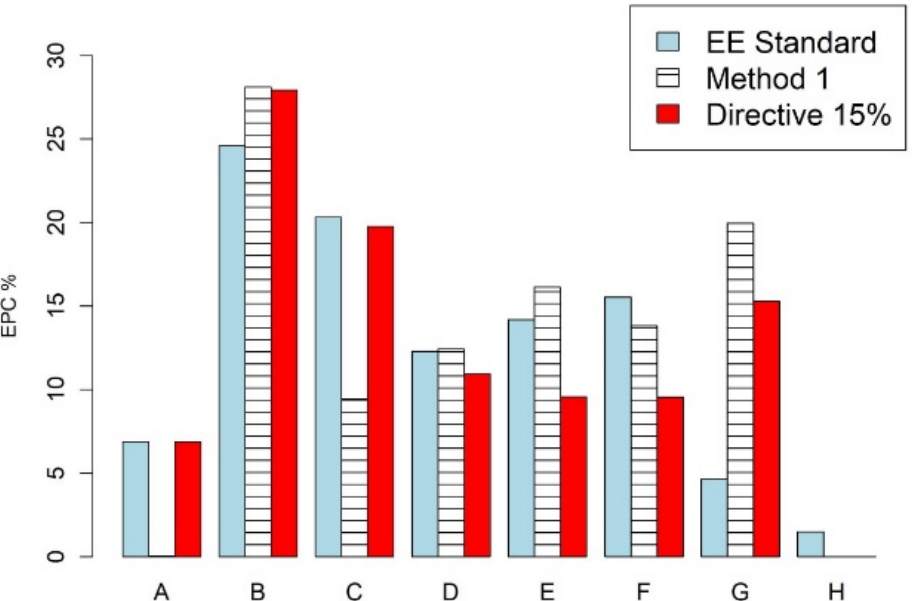
Figure 2. Comparison of number of EPC certificates per class including Directive 15% apartment buildings. Table 7. Upper class boundaries (kWh/(m 2 a)) for Estonian apartment buildings. Cl.